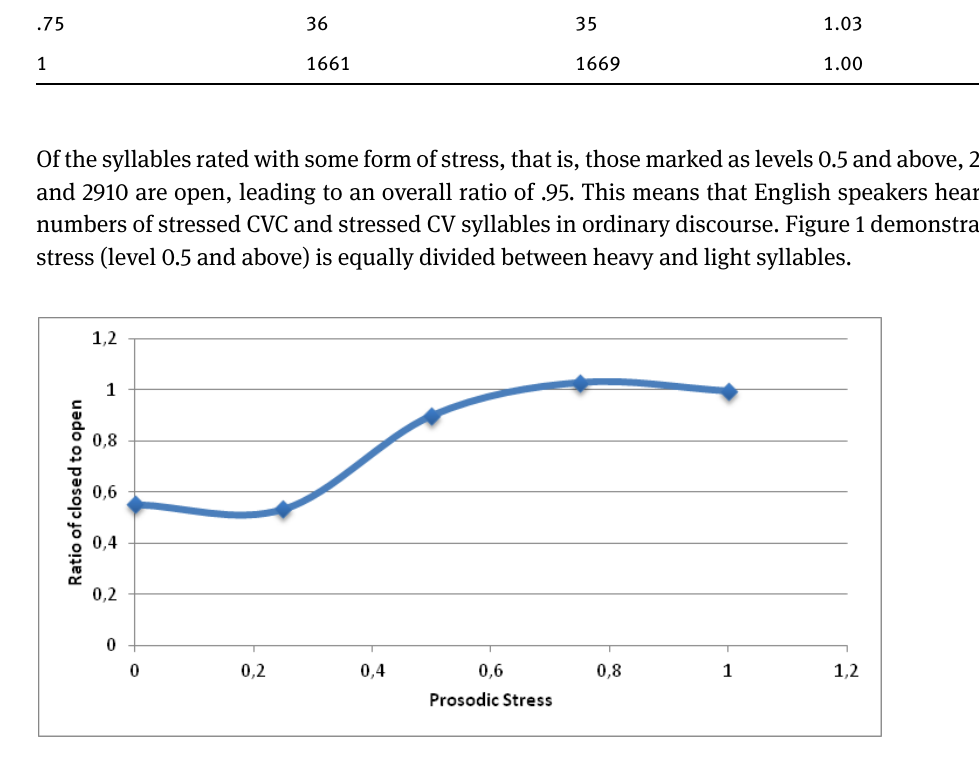
Figure 2. Ratio of closed syllables to open syllable by stress